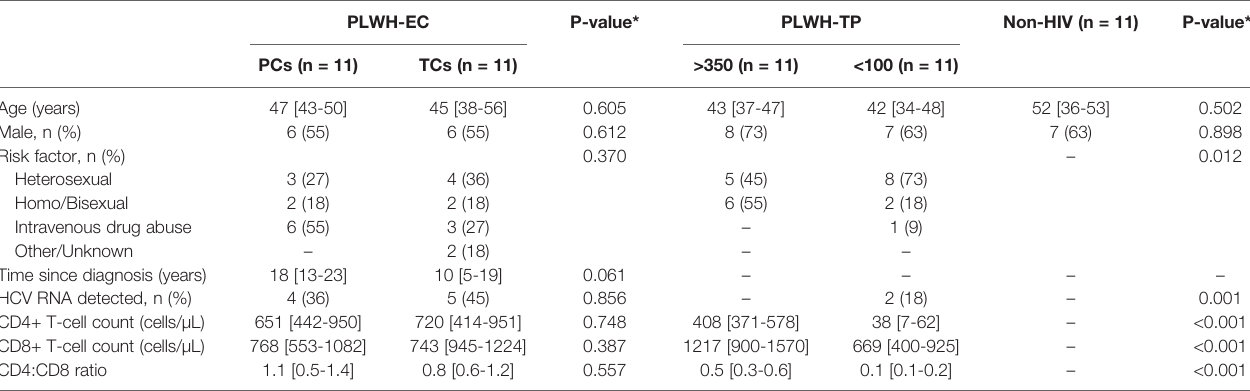
TABLE 1 | Clinical characteristics of the study cohort.